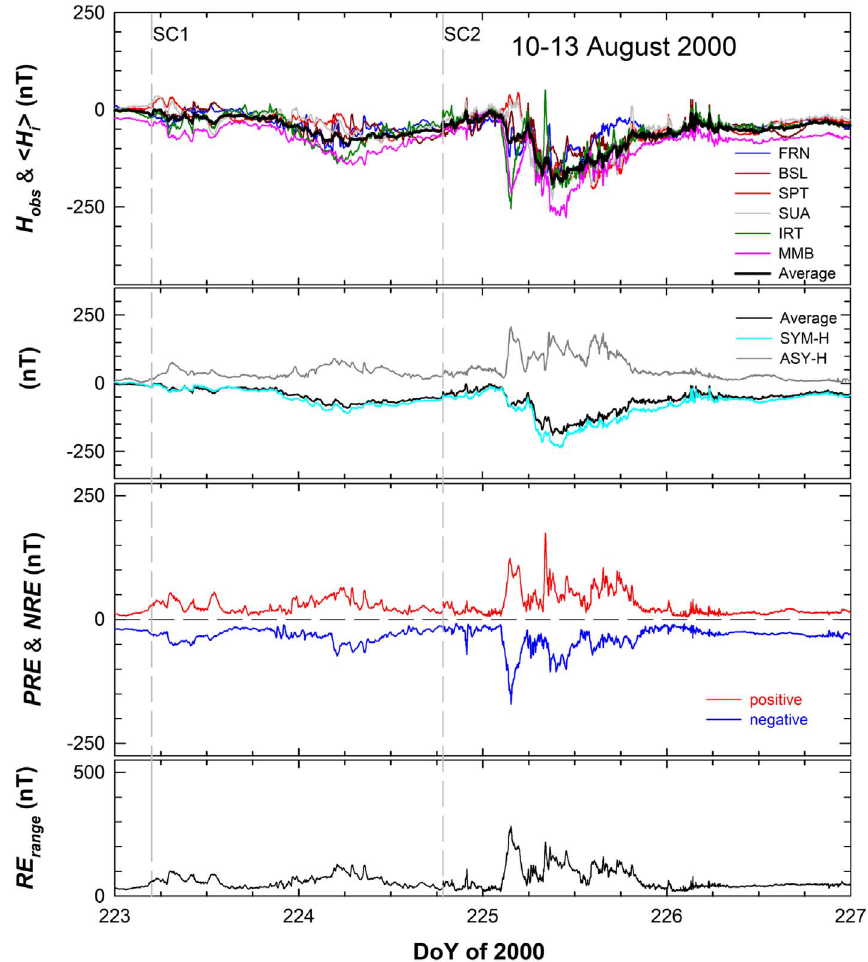
Fig. C.2. The event on 10 – 13 August 2000 (event